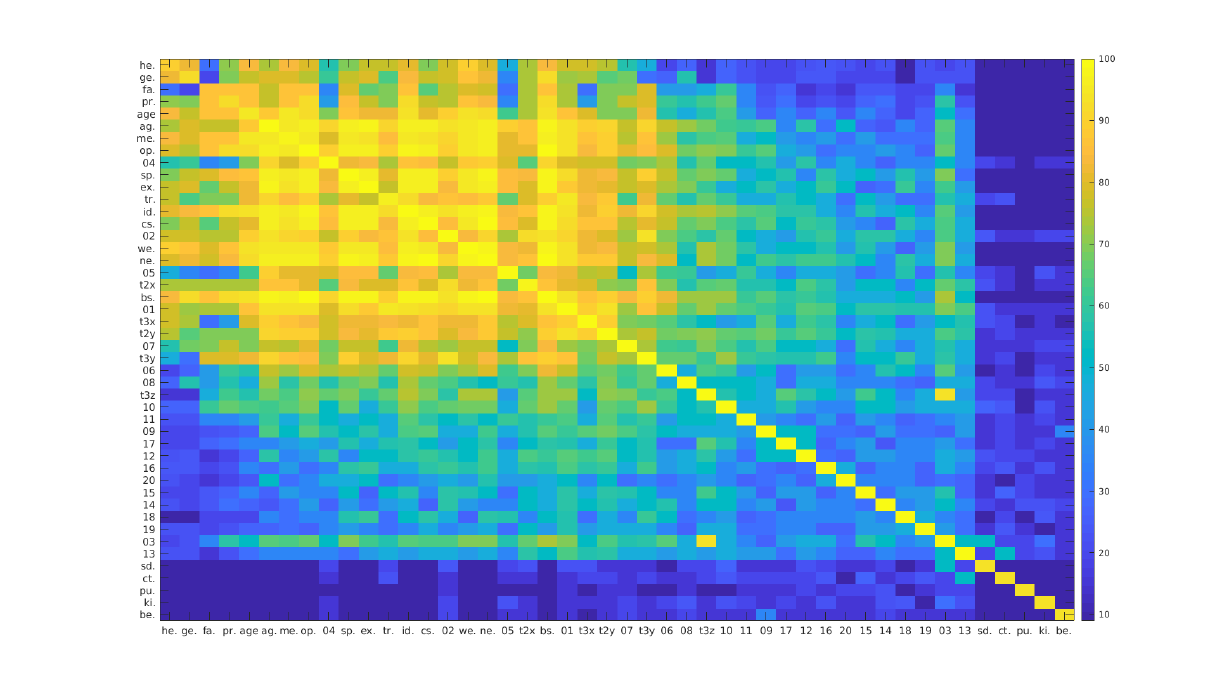
Figure 7. Mutual information between the experimental factors and the trajectory. The different factors including the trajectory are given on both axes, the mutual information of two factors is represented by the colour at the intersection of the row and column belonging to the two factors. The colour coding is given on the bar on the right side. The numbers on the bar represent percentiles of all mutual information values. The different factors are abbreviated in the following way: he.: problems with the right arm or shoulder, ge.: gender, fa.: familiarity with the other participant, pr.: profession, age: age of the participant, ag.: agreeableness, me.: time since last meal, op.: openness, sp.: hours for sports per